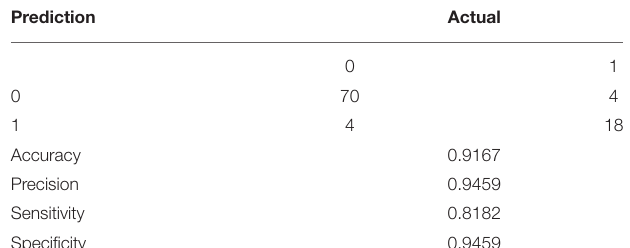
TABLE 2 | Confusion matrix and evaluation indicators of model 1 on the testing set.